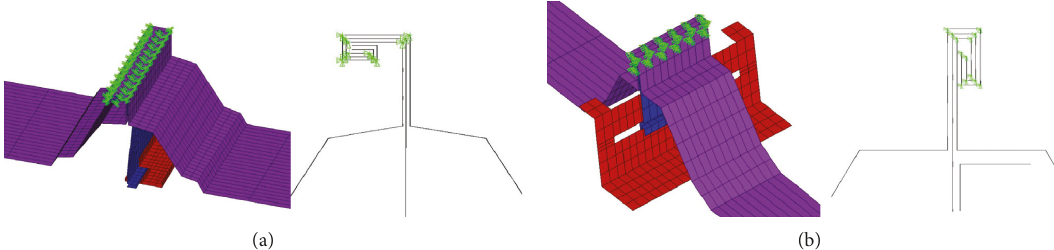
Figure 5: Connection details of roof panels and clips in finite element models. (a) LSIII roof system. (b) SS360 roof system.